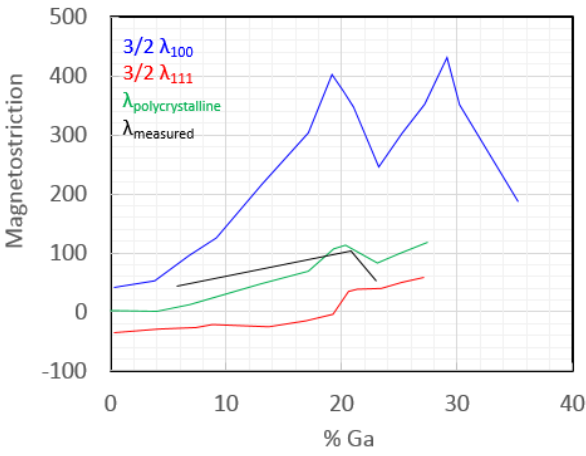
Figure 6. Measured values for the magnetostriction of Galfenol crystallographic orientations and the calculated value of polycrystalline Galfenol, which compares well to measured values [17].